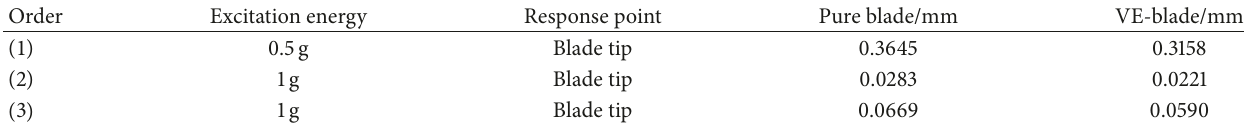
Table 6: Resonant amplitude obtained by test/mm.